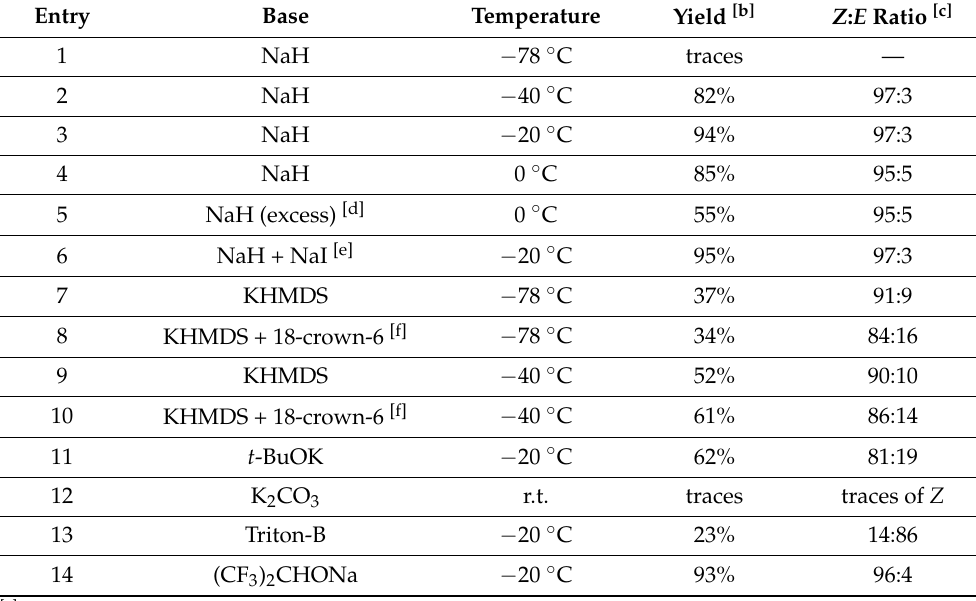
Table 1. Reaction of 1b with benzaldehyde 2a —optimization [a] .